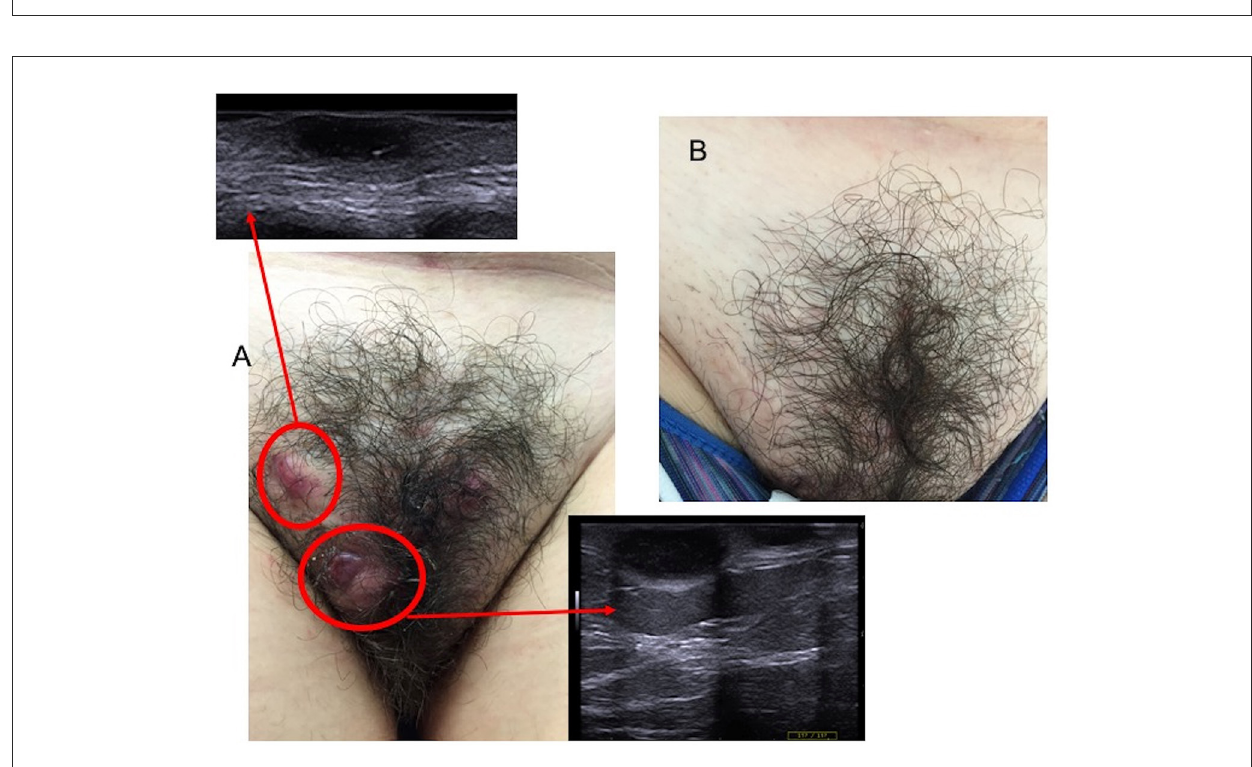
FIGURE2 Nodular lesions of the groin with the ultrasound assessment before cryotherapy (A) , and complete resolution at 3-month follow-up (B) .